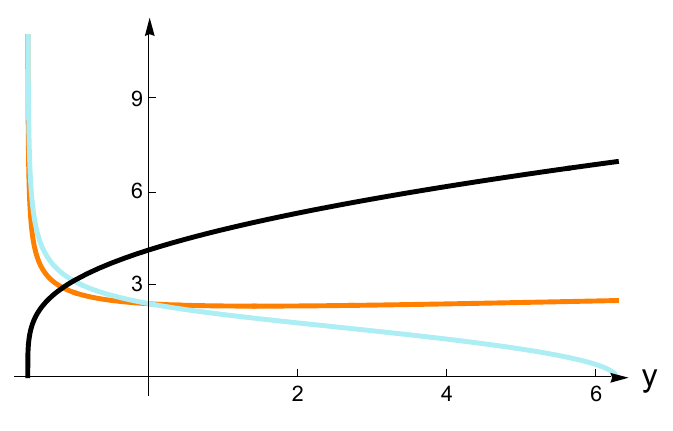
Figure 4 . A numerical solution with M 6 an S 3 -fibration over a three-manifold Σ 3 , interpolating between an O5-plane on the left, and a regular point on the right. The functions are e A (orange), e B (aqua), e C (black). The parameters in (6.62) in this case are a 0 = 2 . 5 , c 0 = 7 , R 0 = 6 , m = − 1